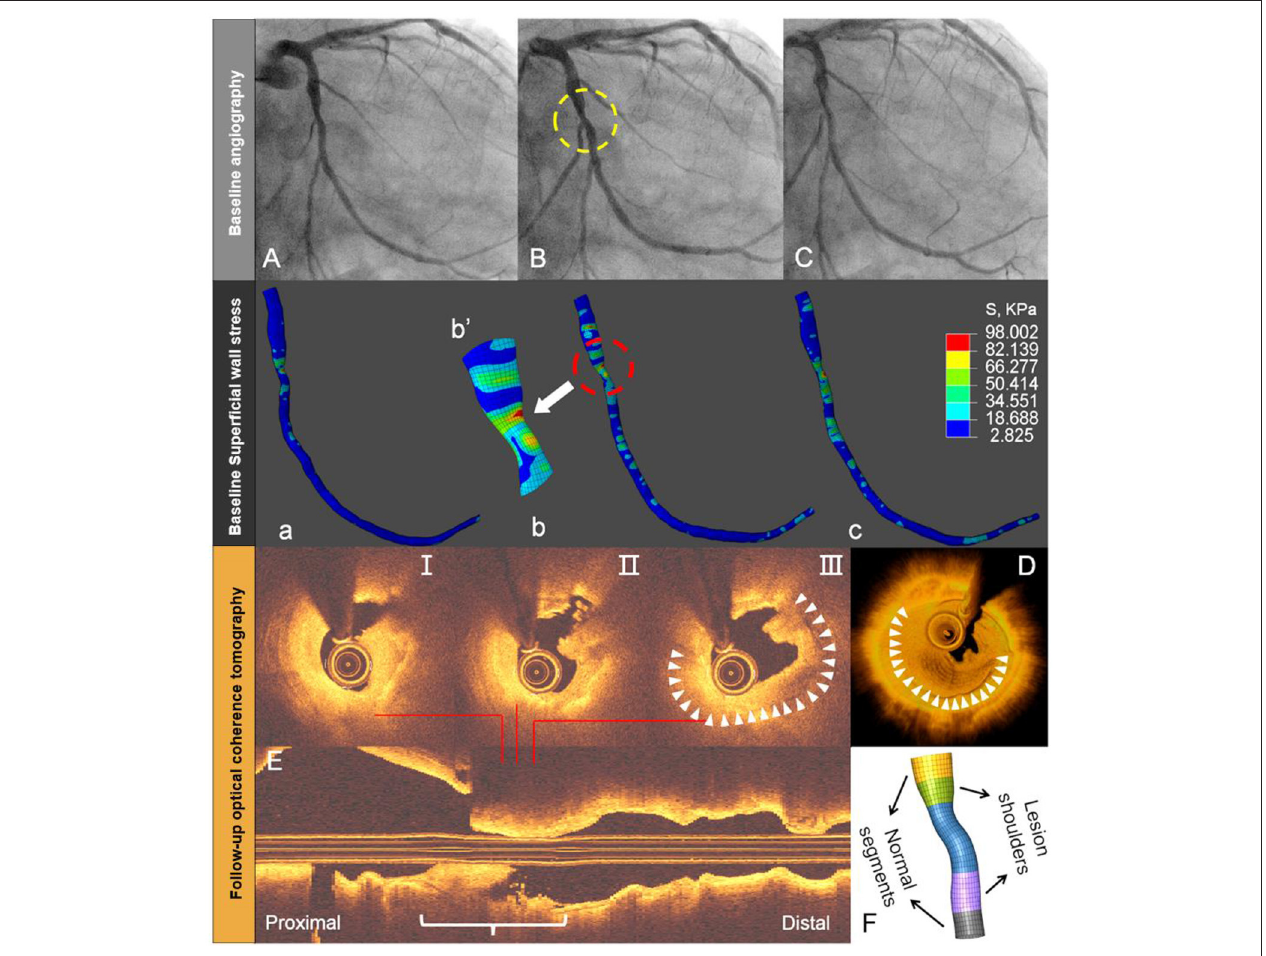
FIGURE 5 | Angiography-based superficial wall stress on diagnostic angiography and late plaque rupture. Baseline angiography shows (yellow circle) an intermediate mid-LCx lesion (A–C) . Superficial wall stress, calculated by the 4D approach at baseline angiography, reveals more local stress concentration in the stenotic segment (white arrow) or throat site (a–c) . This location corresponds with the site of lumen irregularity, thrombus, and plaque rupture during late acute coronary syndrome, as shown by OCT on selected cross-sections (I-III) , 3D rendering (D) , and longitudinal OCT (E) . The reconstructed throat segment and lesion shoulders are shown along with percent diameter stenosis (F) . Modified from Wu et al. (